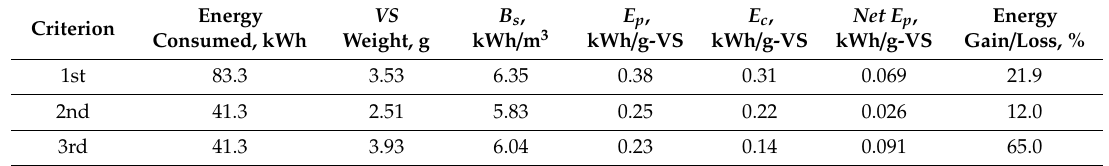
Table 10. The energy balance based on each optimisation